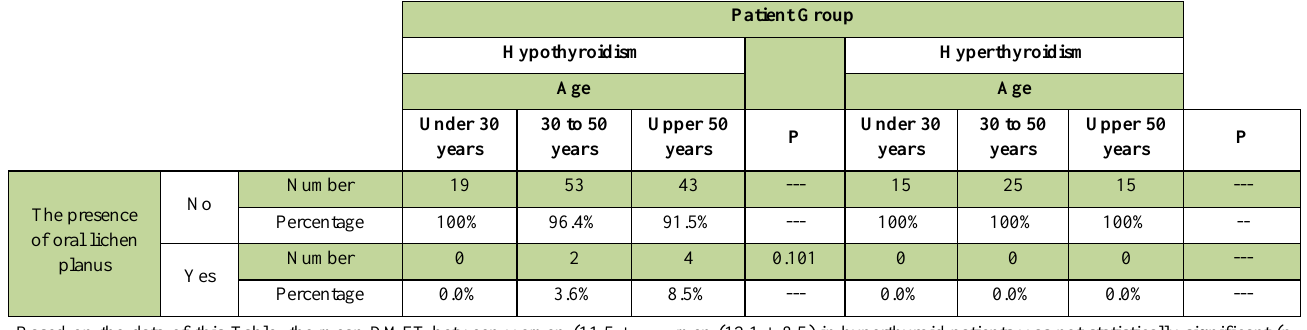
Table 6. Prevalence of oral lesions in two groups of patients based on age.